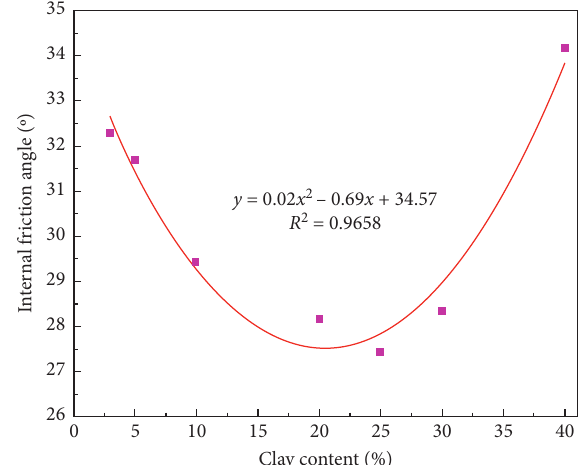
Figure 9: Relationship between clay content and internal friction